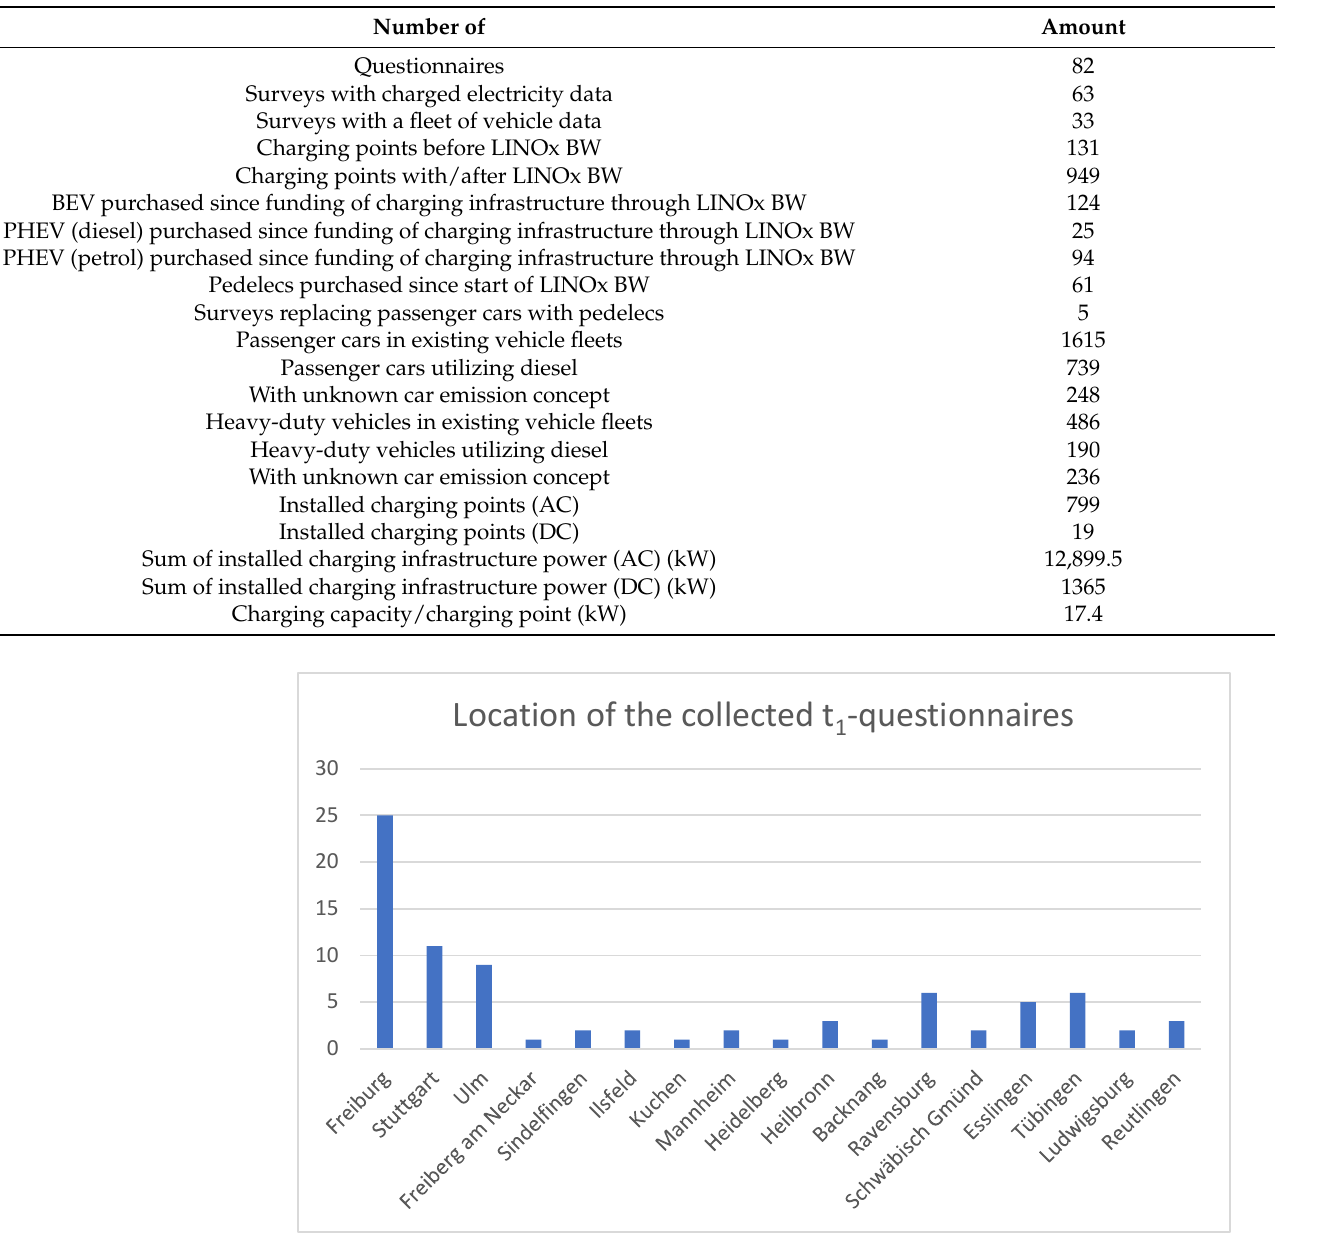
1 -questionnaires within LINOx BW